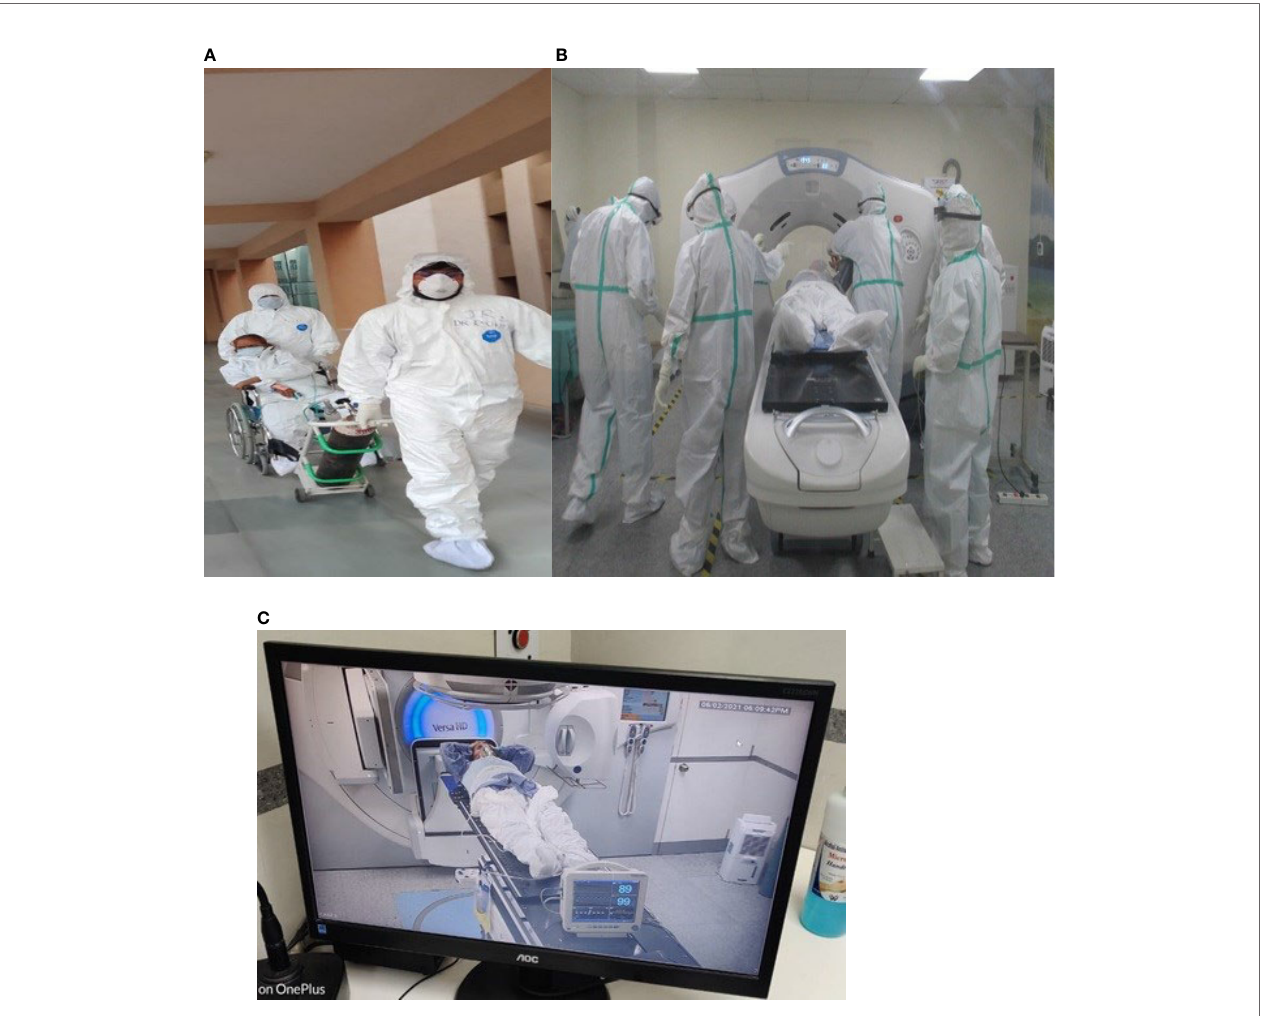
FIGURE 1 | (A) (left) and (B) (right): Show the transfer and CT Simulation of the COVID 19 patients enrolled in our trial, maintaining proper personal protection. (C) Shows the continuous Surveillance and Monitoring of the patient during the delivery of